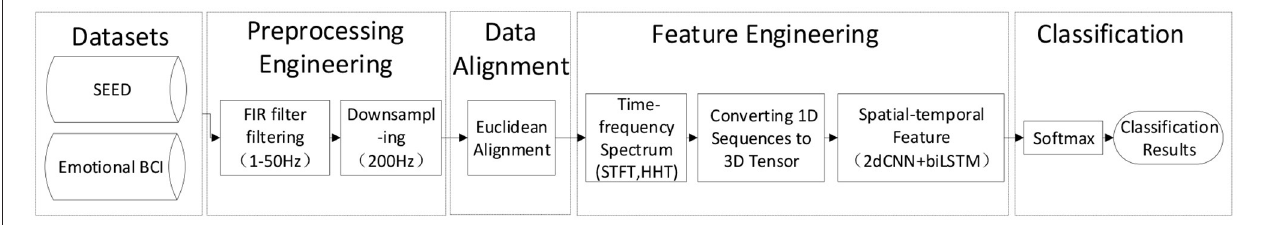
FIGURE 1 | Cross-database emotion recognition framework based on electroencephalogram (EEG) signals. Emotional BCI Competition Database is the training set of the Emotional BCI in 2020WORLDROBOT COMPETITION-BCI CONTROL BRAIN ROBOT CONTEST Emotional BCI in 2020 WORLD ROBOT COMPETITION-BCI CONTROL BRAIN ROBOT CONTEST.